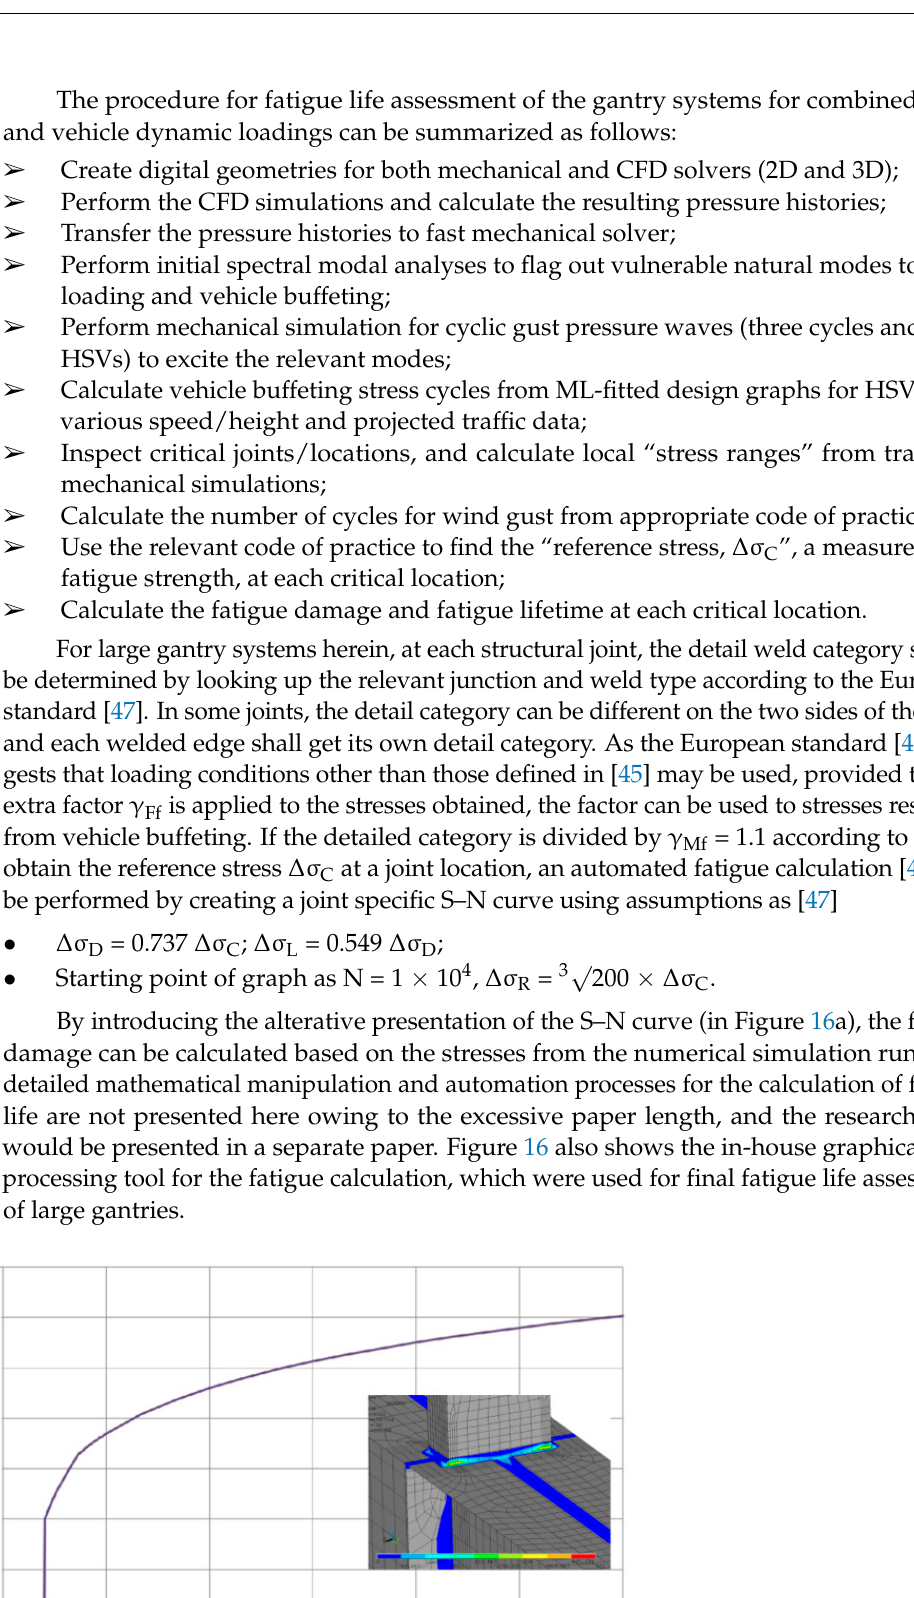
Figure 16. ( a ) Fatigue damage alternative mathematical representation for detailed stress cycles; ( b ) transient gust pressure loading pattern with structural response and results of graphical post- processing tool [48]. 8. Conclusions The integration of design and simulation has been a long-standing open challenge for scientist and practicing engineers in the area of complex engineering systems. In the research work herein, conventional simulation techniques and their discretization meth- ods were scrutinized and the application of the new dynamic zone method for the large engineering systems was investigated. The technique has already made some design im- pacts in which design rules were extracted from the large simulation scenario tables using verified numerical results. While in the conventional numerical techniques, it is hard to taken into account the effect of dynamic changes and their propagation within the domain, an alternative dy- namic zone technique can be employed. The introduction of virtual boundaries, mathe- matical void zones, and genetic algorithm symbolic regression concepts can facilitate the formulation of the next generation of numerical techniques for practical design applica- tions. In the research work herein, it is intended to identify and formulate the necessary vibrational aspects of the engineering system design and employ an innovative numerical solver technique using the full-parallel processing scheme. In the first part of the paper, the basic concepts of the finite zoning technique and its discretization/interfacing schemes were briefly presented, while in the later sections, the